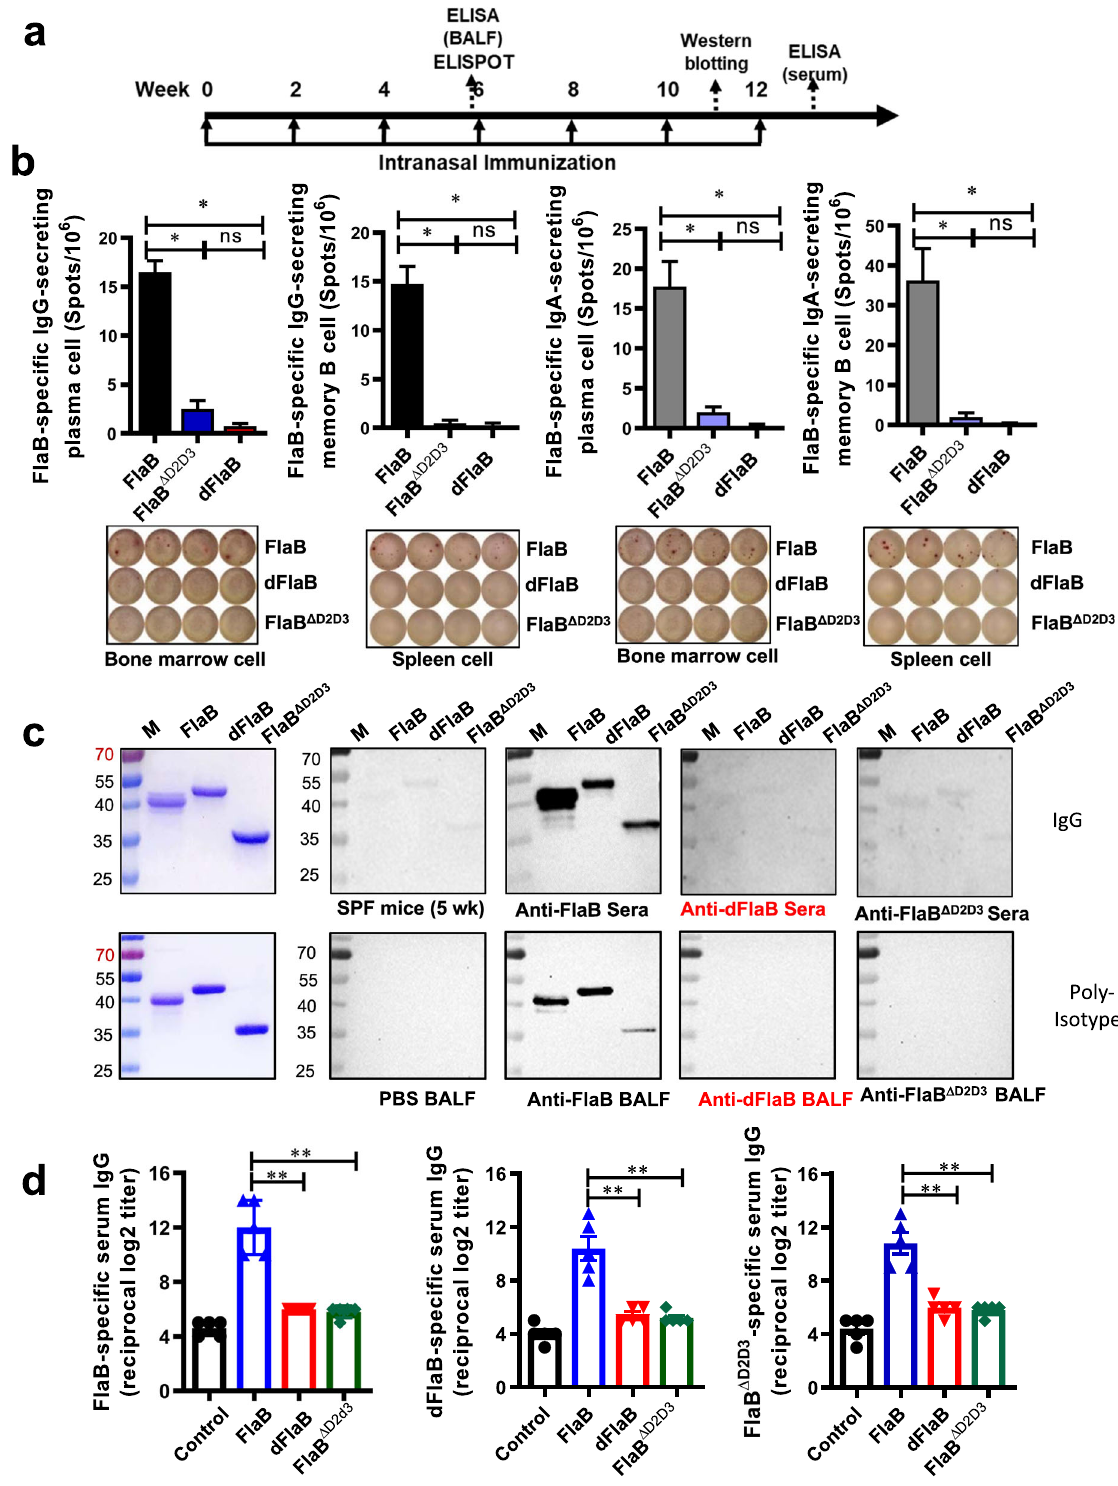
vs 0.08 μ g sH1N1 + FlaB) (Fig. 6a). To test virus-neutralization capacity of anti-sera, we performed a virus plaque reduction neutralization test (PRNT). As shown in Fig. 6b, FlaB- or dFlaB- adjuvanted vaccine showed signi fi cantly higher titers than the 0.2 μ g sH1N1 alone ( P < 0.05 for 0.2 μ g sH1N1 vs 0.2 μ g sH1N1 + Published in partnership with the Sealy Institute for Vaccine